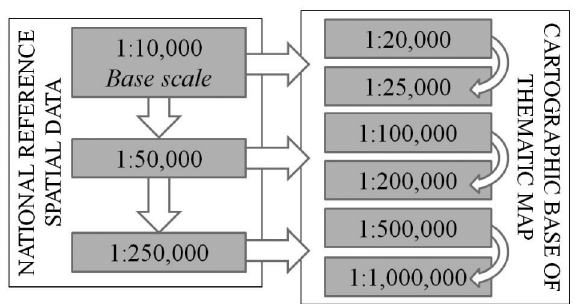
Fig. 1. Example of source data for generalisation depending on scale of spatial data (map) in